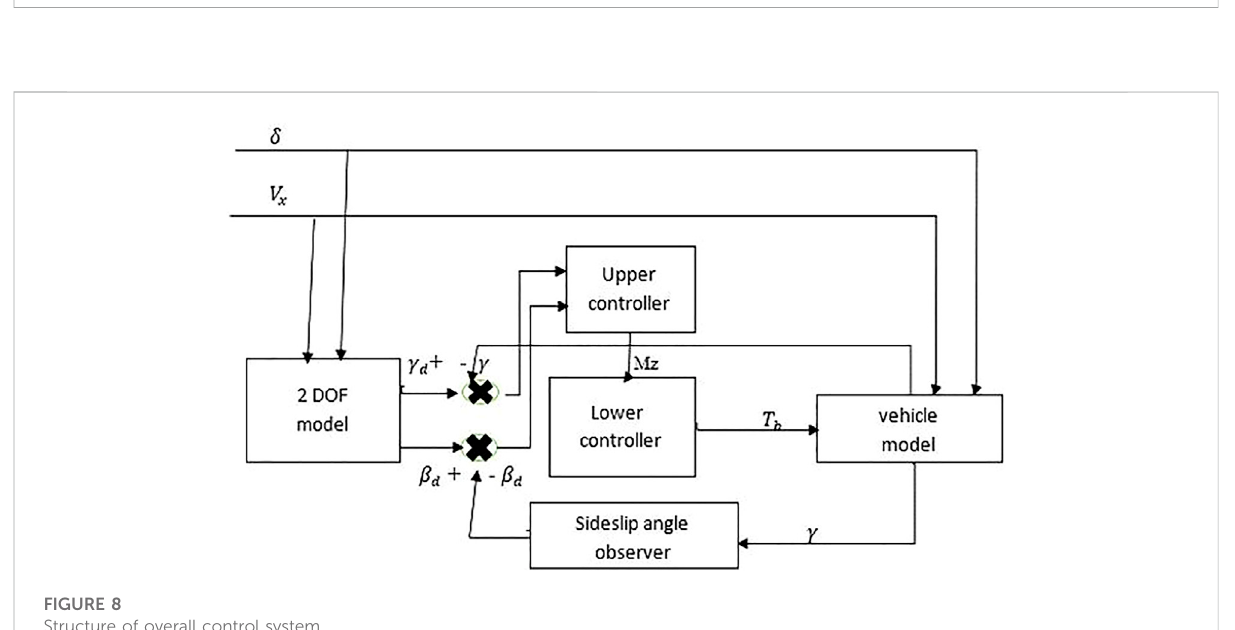
FIGURE 8 Structure of overall control